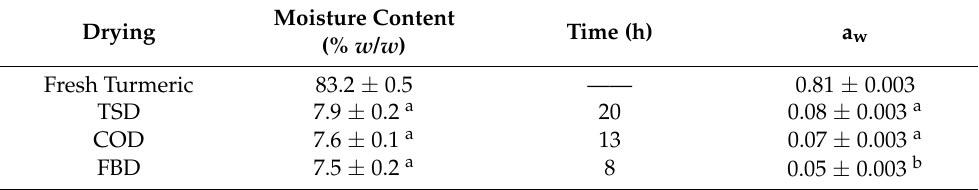
Table 1. Moisture content and water activity for fresh and dried